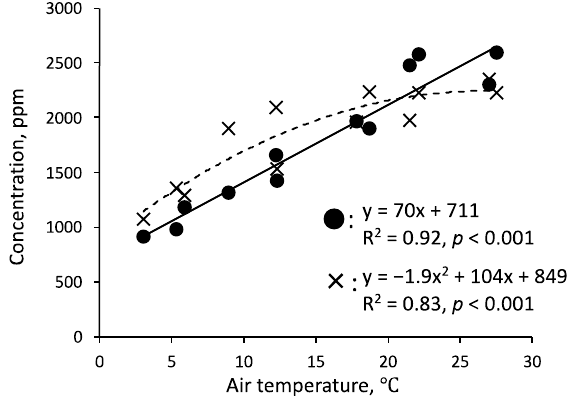
Figure 6. Relationship between monthly concentrations of K in the xylem sap obtained in